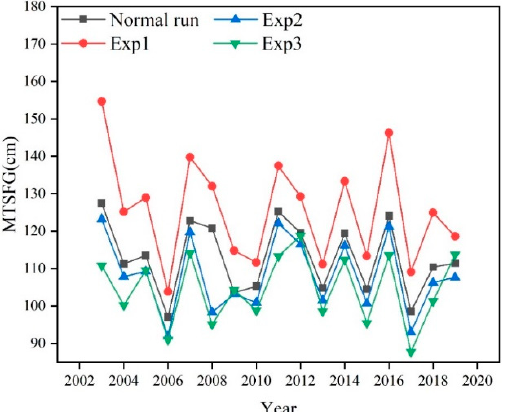
Figure 9. Changes in the basin-averaged MTSFG in the period from 2003 to 2019, estimated by remote sensing in the normal run, exp1, exp2 and exp3.